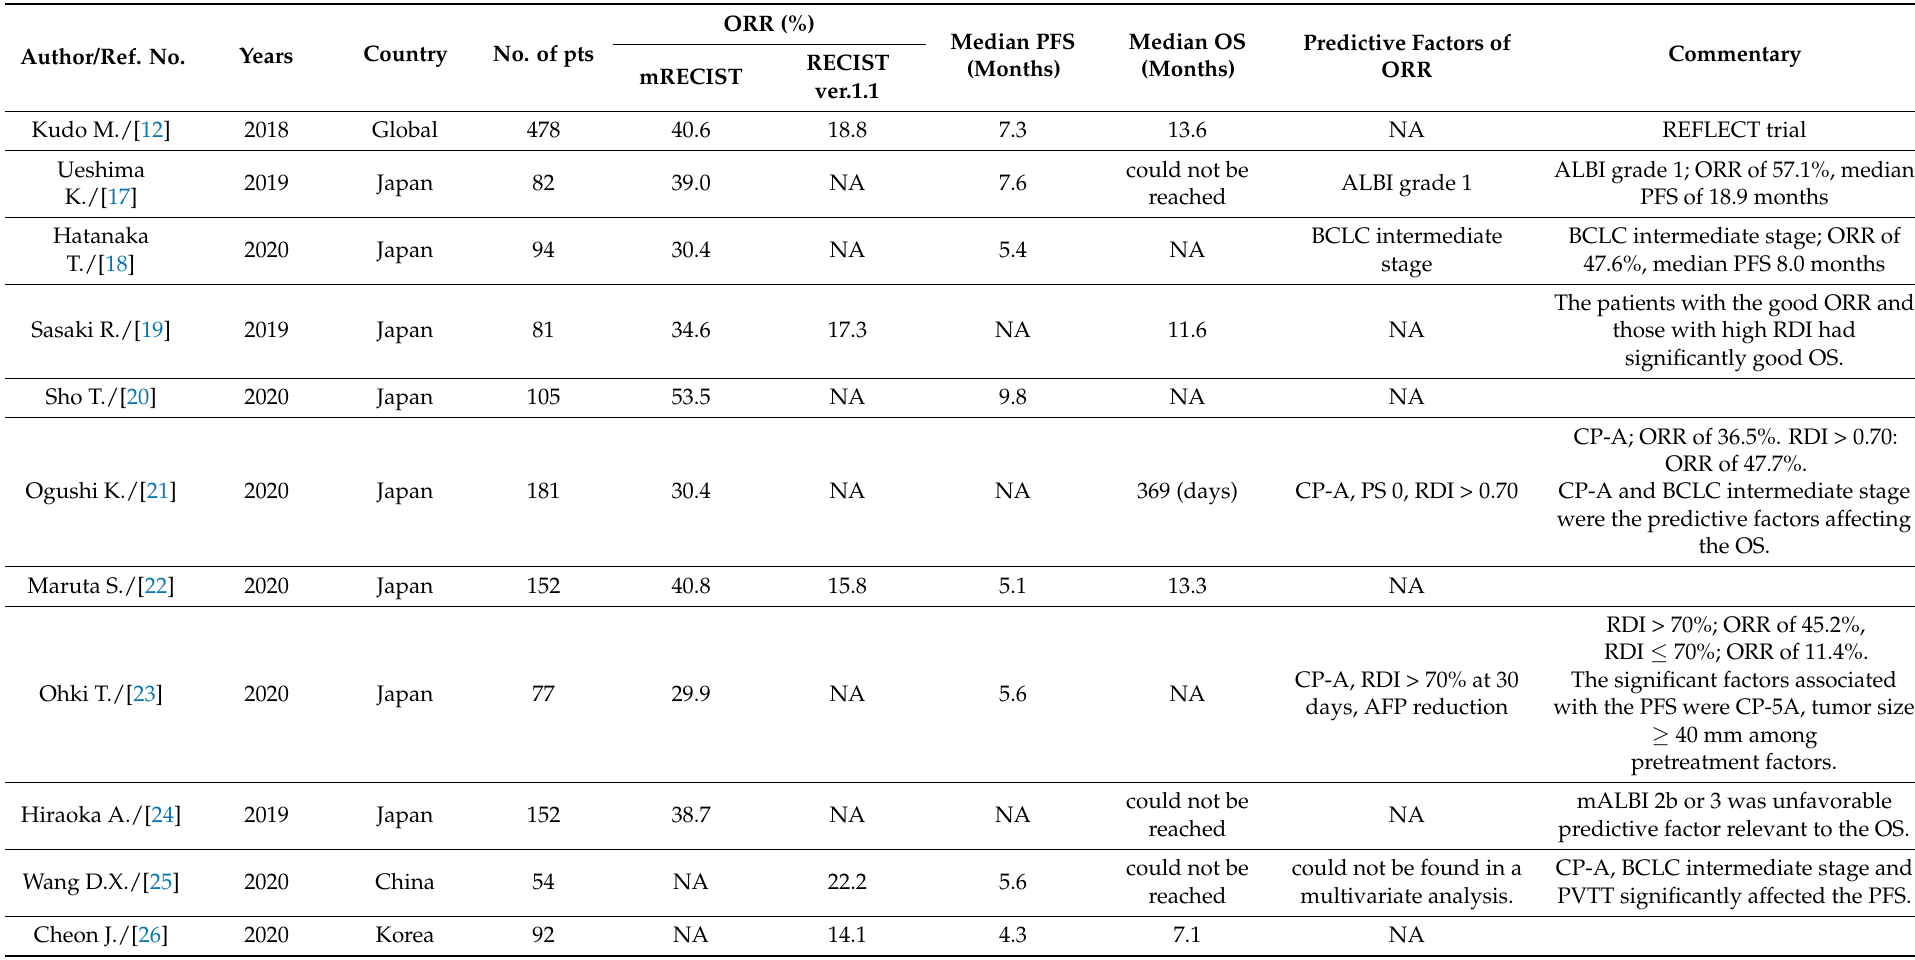
Table 1. The therapeutic response to lenvatinib